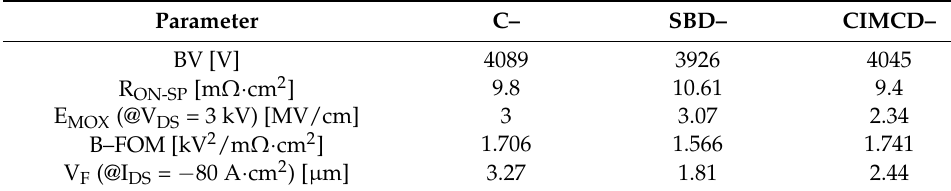
Figure 6. ( a ) Third quadrants characteristics of C–DMOSFET, SBD–MOSFET, and CIMCD–MOSFET. ( b ) Variation of diode turn-on voltage (V F ) and oxide edge maximum electric field of CIMCD-MOSFET with Tox 2 . Table 2. Static characteristics of devices.